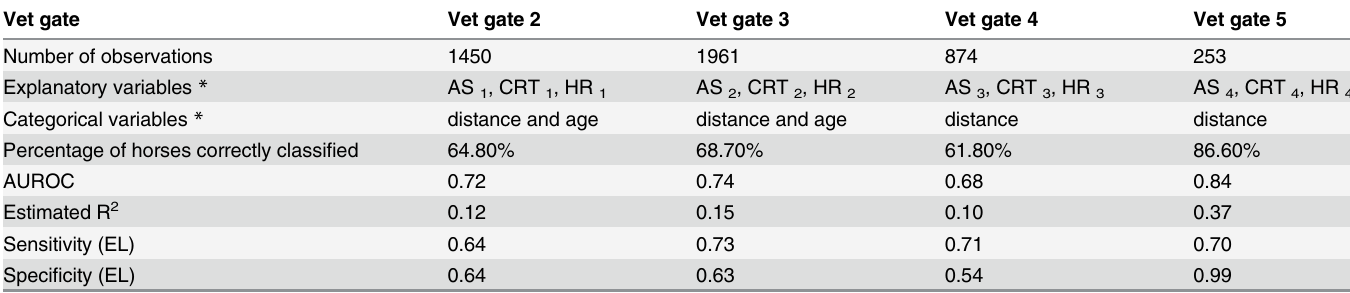
Table 3. Results of the logistic regressions used to estimate the probability of elimination at each vet gate (based on variables recorded at the pre- vious vet gate). Vet